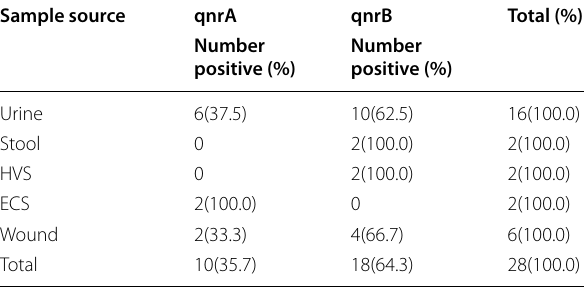
Table 5 The distribution of fluoroquinolone-resistant genes, qnrA and qnrB among the sample sources